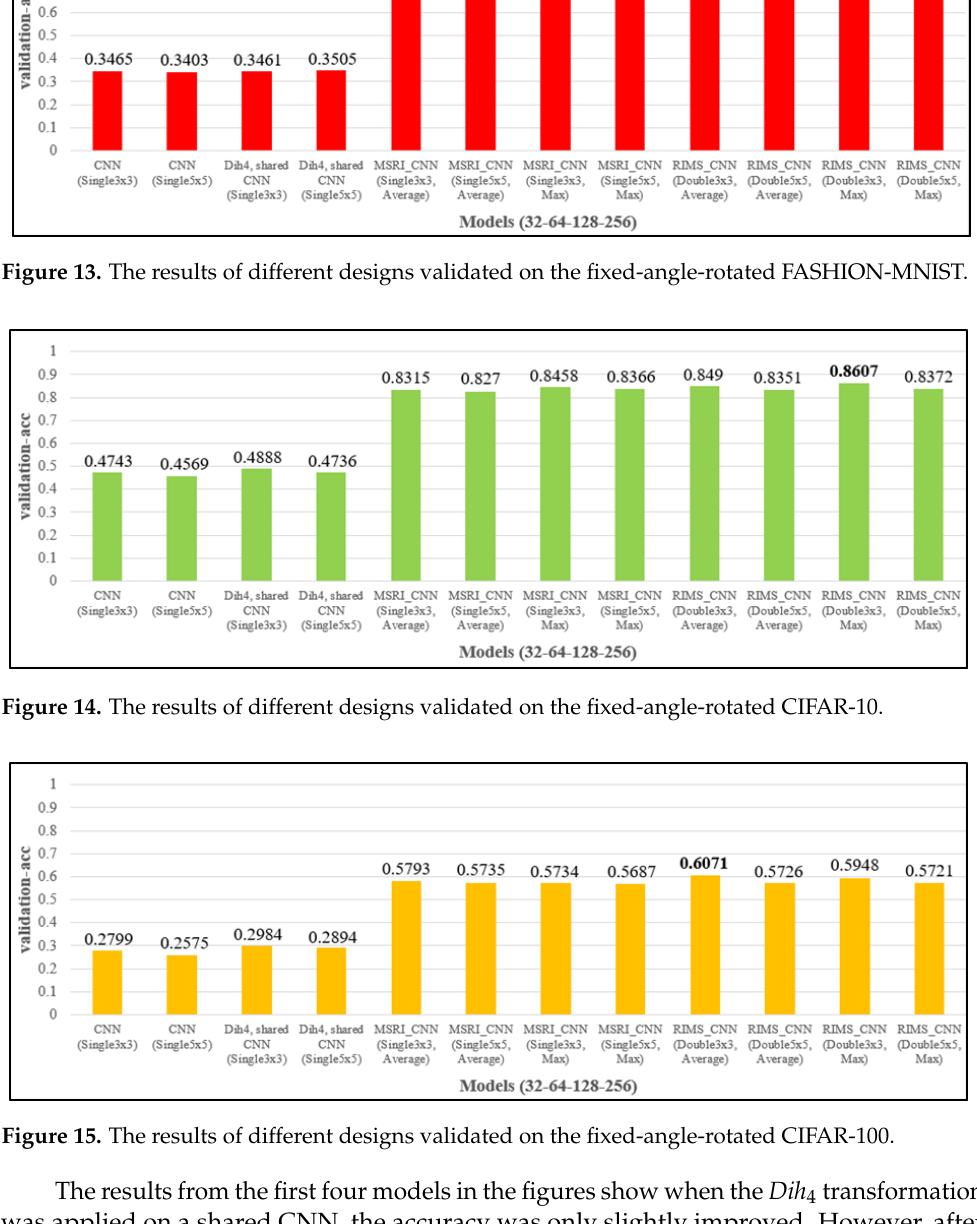
Figure 15. The results of different designs validated on the fixed-angle-rotated CIFAR-100.